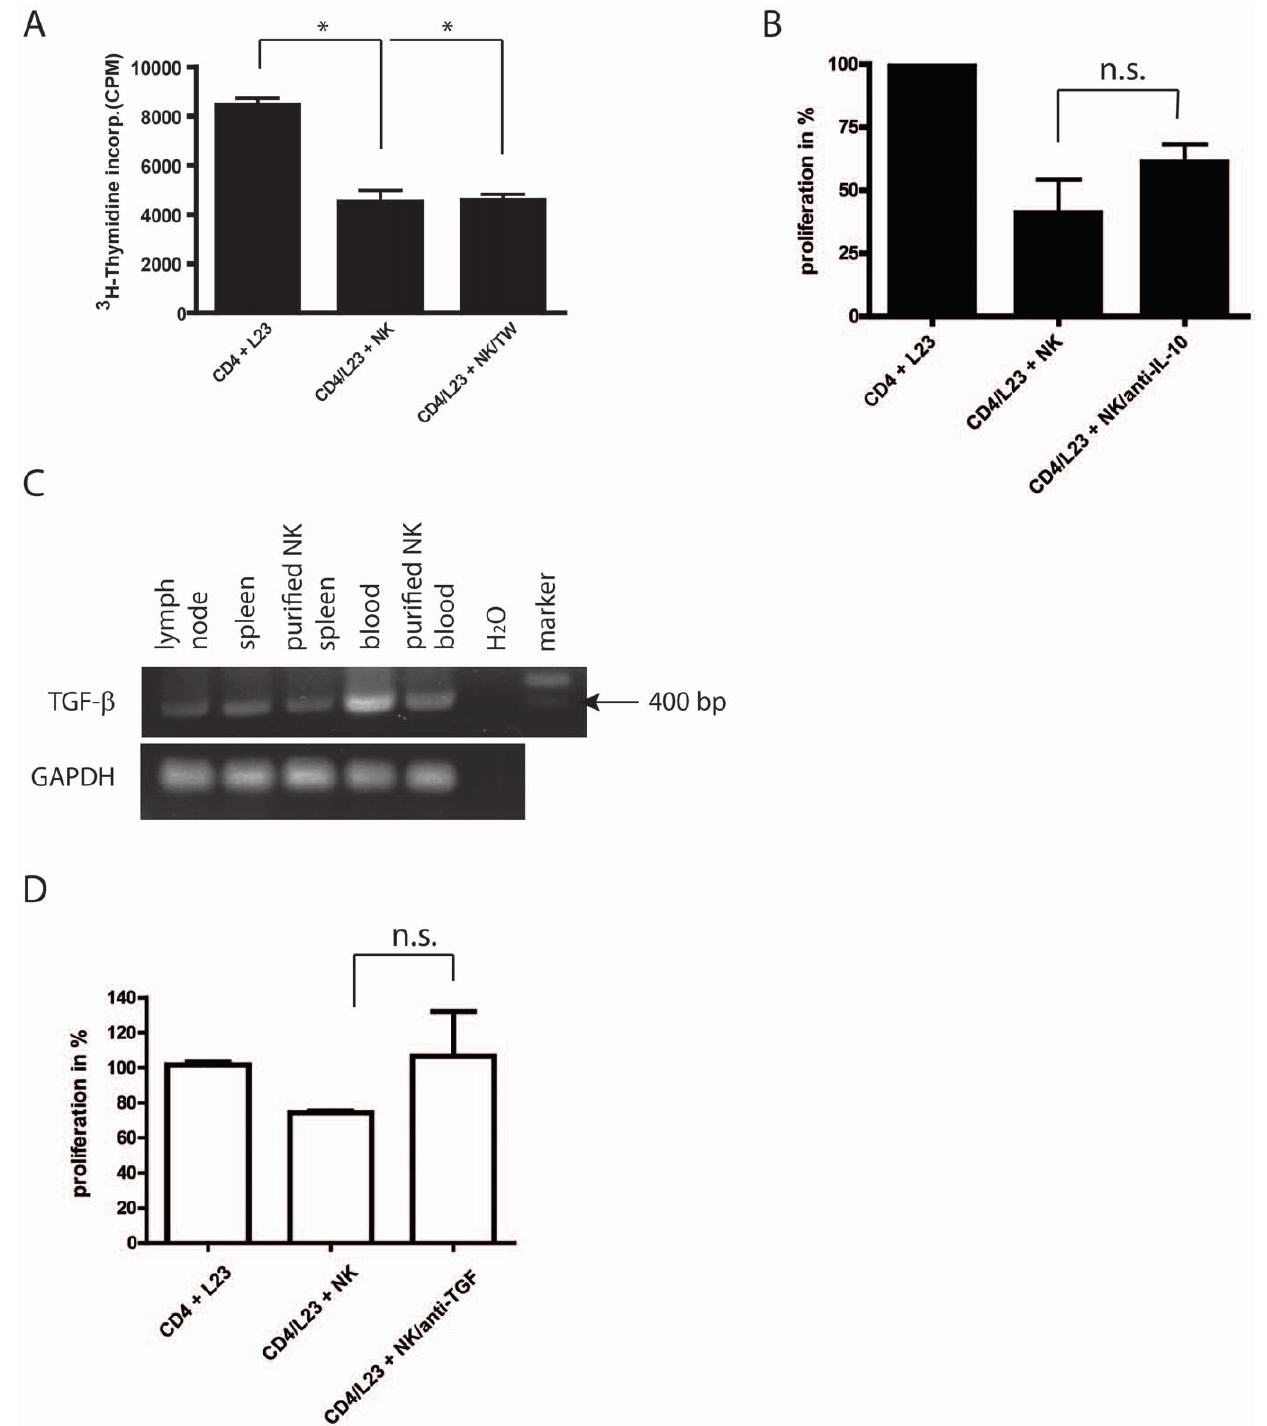
Figure 5. Control of CD4 + T cell proliferation by naı¨ve NK cells is mediated by TGF- b . A: To evaluate the factors preventing proliferative T cell response, 2 6 10 5 isolated CD4 + T cells as main responder to L23 stimulation (2 6 10 3 cells) were incubated with 2 6 10 4 NK cells directly or separated by a transwell (TW) from T cells and L23. The response of T cells was inhibited by NK cells independently on the possibility of contact formation. B: MLR with purified CD4 + T cells and NK cells in the presence of anti-IL-10 antibodies. IL-10 has known regulatory function and NK cells have been described to secrete IL-10. However, blockage of IL-10 with neutralising antibodies resulted only in a weak recovery of proliferation. Thus, IL-10 might play a role in regulation of T cells by NK cells but not basically. C: Assessment of TGF- b mRNA expression in bulk lymph node cells, splenocytes and of blood derived lymphocytes in comparison to purified NK cells. Lymphocytes were isolated from naive LEW.BH-NKC rats and subsequently prepared for mRNA isolation. The expression of TGF- b was compared to the house keeping gene GAPDH. TGF- b was detectable in bulk fractions and purified naive NK cells however relatively weak in lymph node cells of naive rats. D: Neutralisation of TGF- b using mAb in MLR of 2 6 10 5 purified CD4 + T cells derived from LEW.BH-NKC rats in the presence of 2 6 10 4 negative isolated NK cells. T cells were stimulated with 2 6 10 3 L23 cells